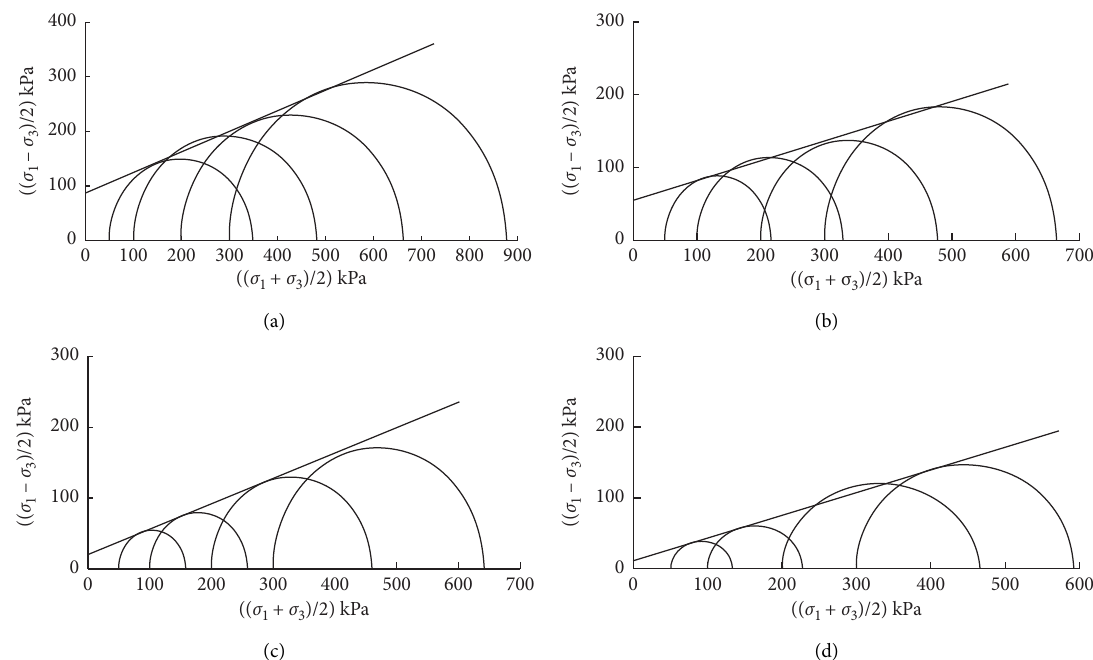
Figure 10: Mohr circles and strength envelopes of the samples with 25% initial moisture content at different numbers of cycles. Mohr circle and strength envelope (a) during the initial state, (b) in a dry-wet cycle, (c) in three dry-wet cycles, and (d) in five dry-wet cycles.